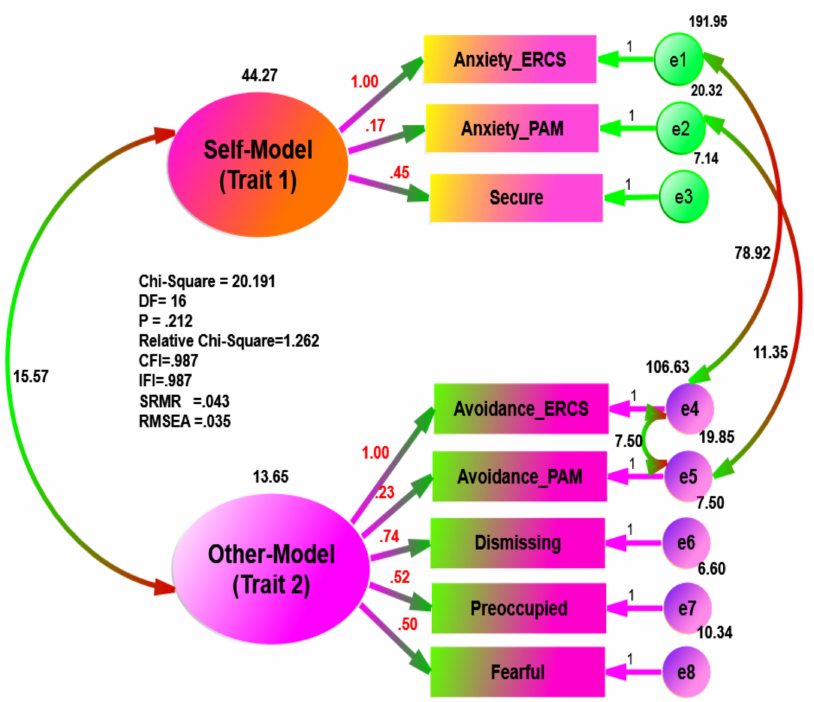
Figure 5. Multi-Traits of Hypothesized Measurement Models of the Attachment Theory in Psychiatric